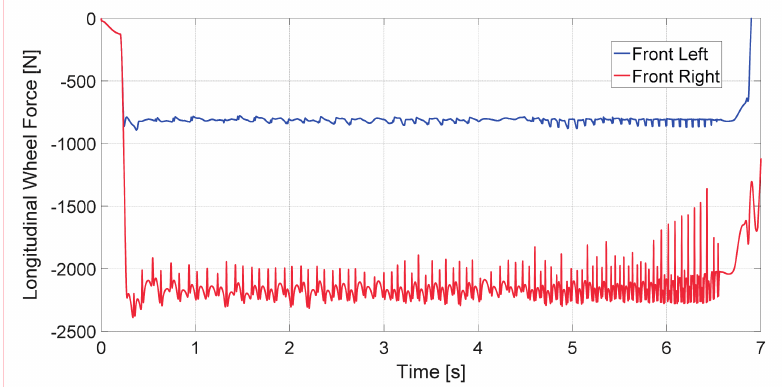
Figure 5. Longitudinal force of the front left wheel (blue line) and front right wheel (red line) during the split-mu braking test.